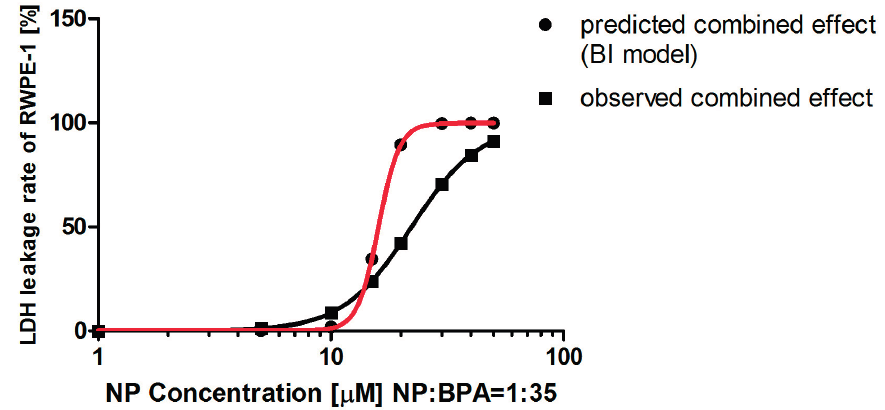
Figure 4. Comparison of observed and predicted lactate dehydrogenase (LDH) leakage rate caused by a combination of nonylphenol (NP) and bisphenol A (BPA). The predicted concentration-response curve of the mixture matched the data calculated from the Bliss independence (BI) models. Components were mixed in a fixed ratio based on their individual EC 50 values. The two curves both satisfied the Hill